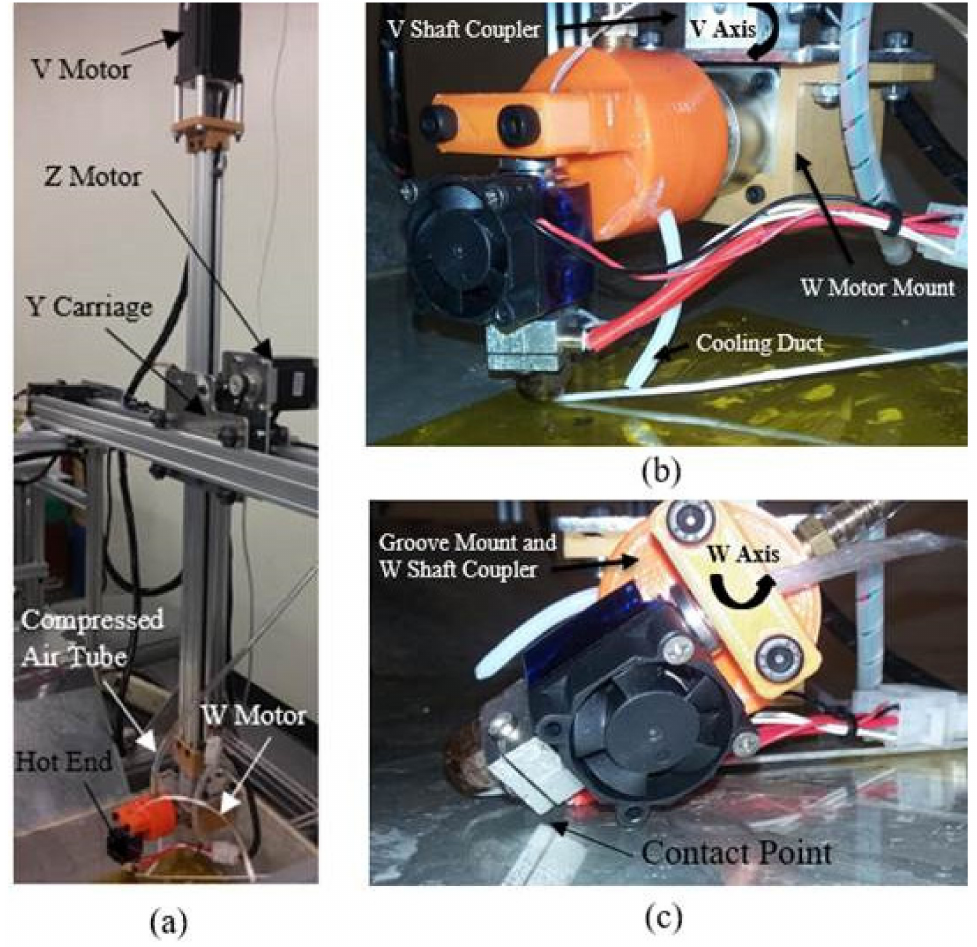
Figure 2. ( a ) Five-axis system; ( b ) W-axis armature; ( c ) max placement angle of